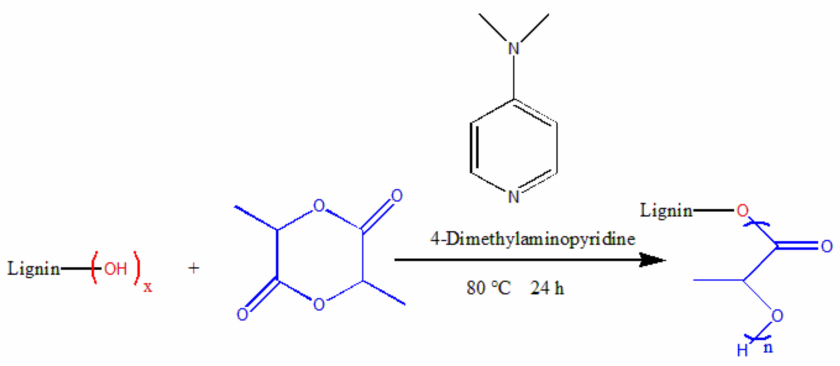
Figure 6. Synthesis of graft copolymers lignin-g-polylactic